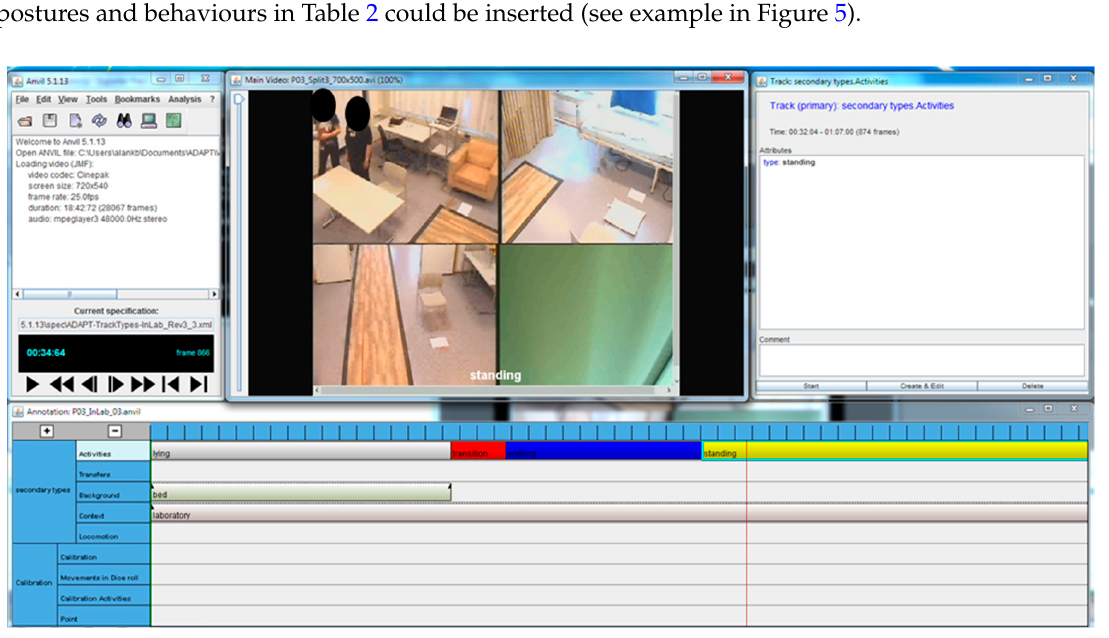
Figure 5. Screenprint of the Anvile software. The general postures and behaviors are visualized as boxes/rectangles on parallel tracks along a horizontal timeline. An exported frame-by-frame output was used for analysis.